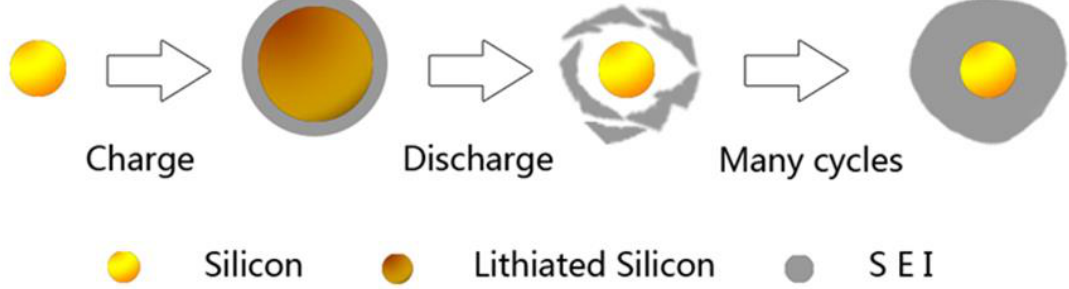
Figure 2. Schematic diagram of formation process of SEI film around the surface of silicon during charge-discharge cycles. The volume effect of silicon-lithium alloy makes it impossible to form a stable SEI film.